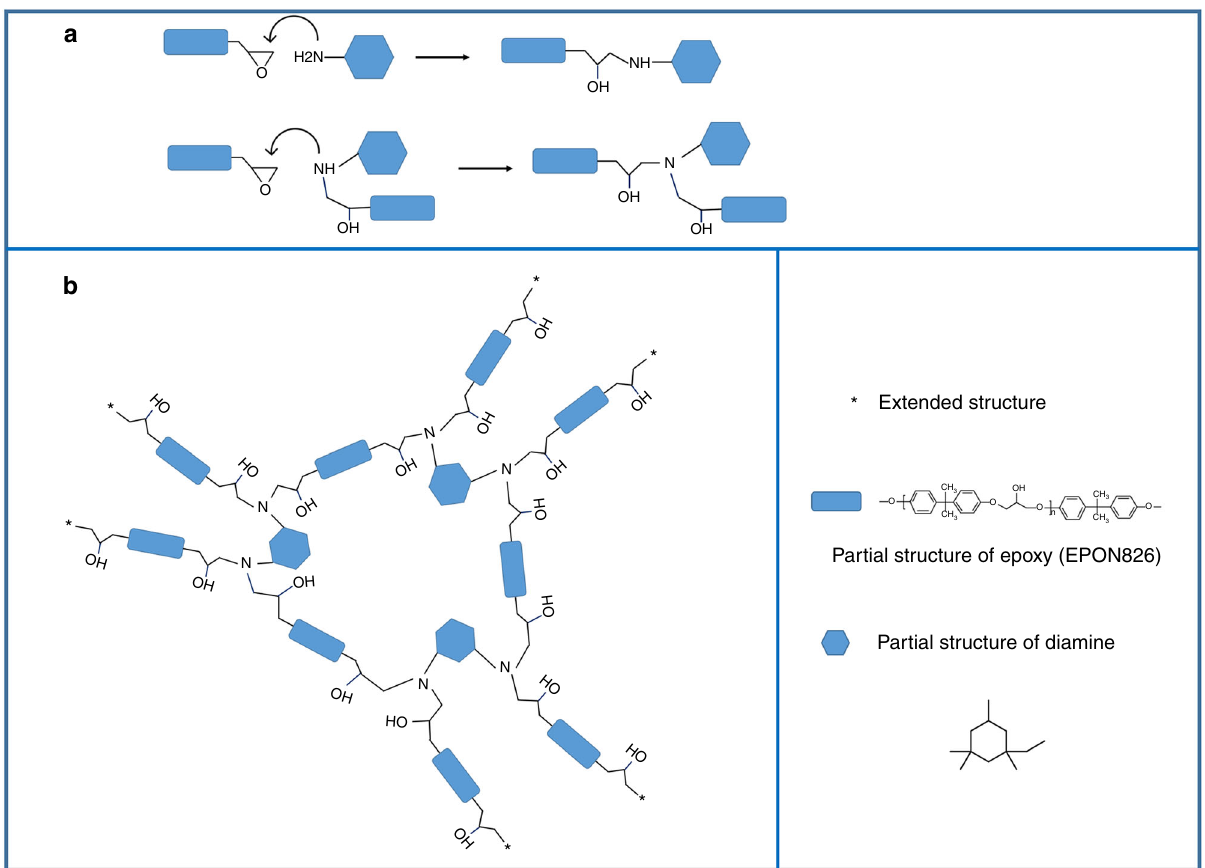
Fig. 5 The possible reaction pathway for the EPON – IPD network. a Presents how one amino group reacts with an epoxy group. b Shows the network formed by nine EPON 826 and three IPD molecules. The stars indicate the extension of the rest of the